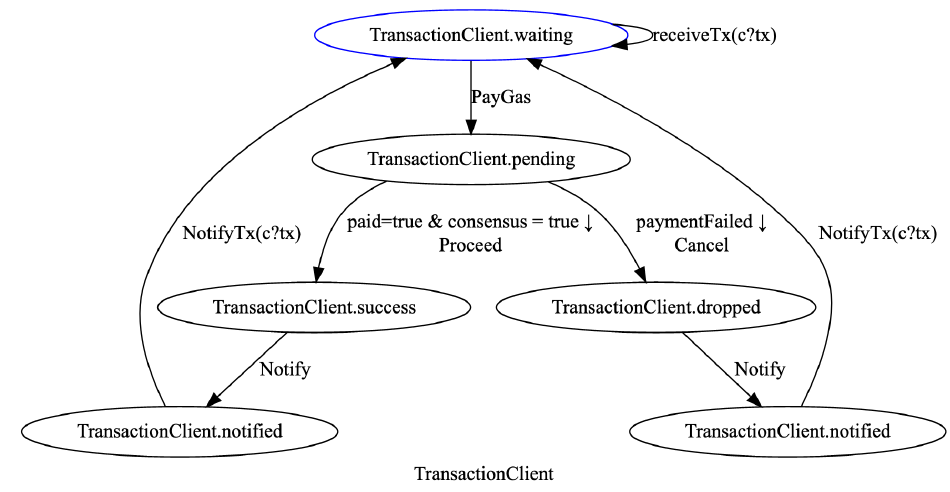
Figure 7. Visualized system graph of the transaction client in